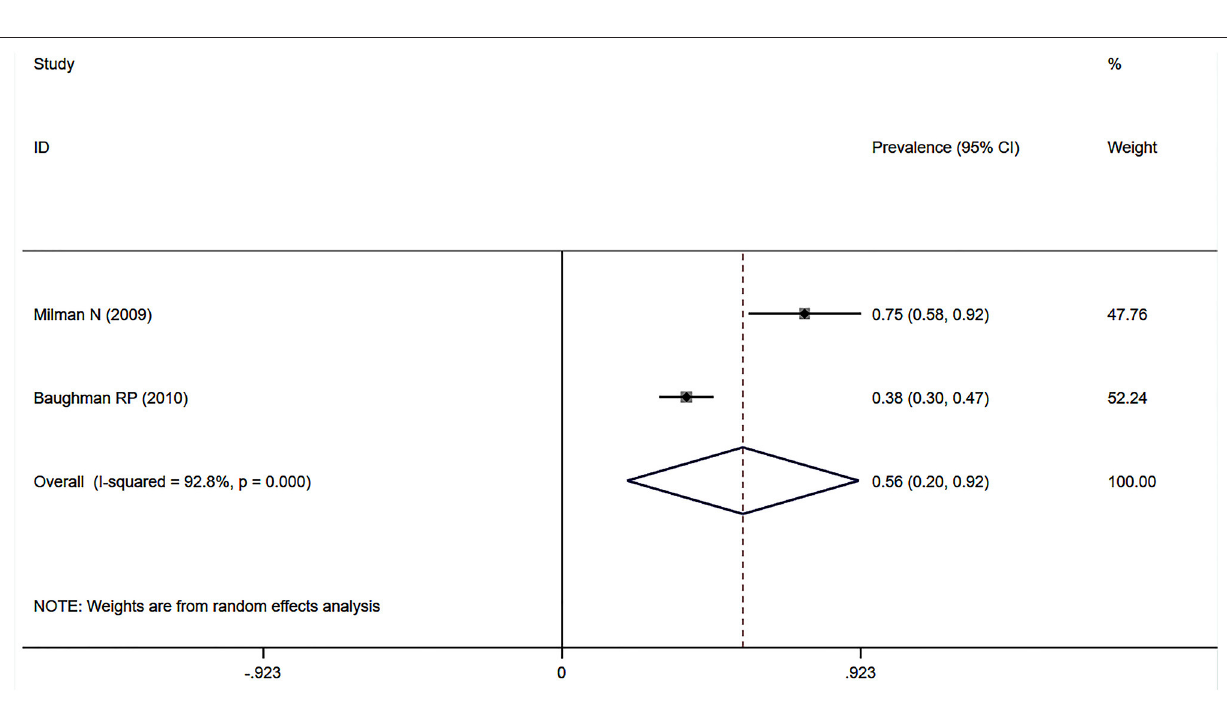
Frontiers in Cardiovascular Medicine |